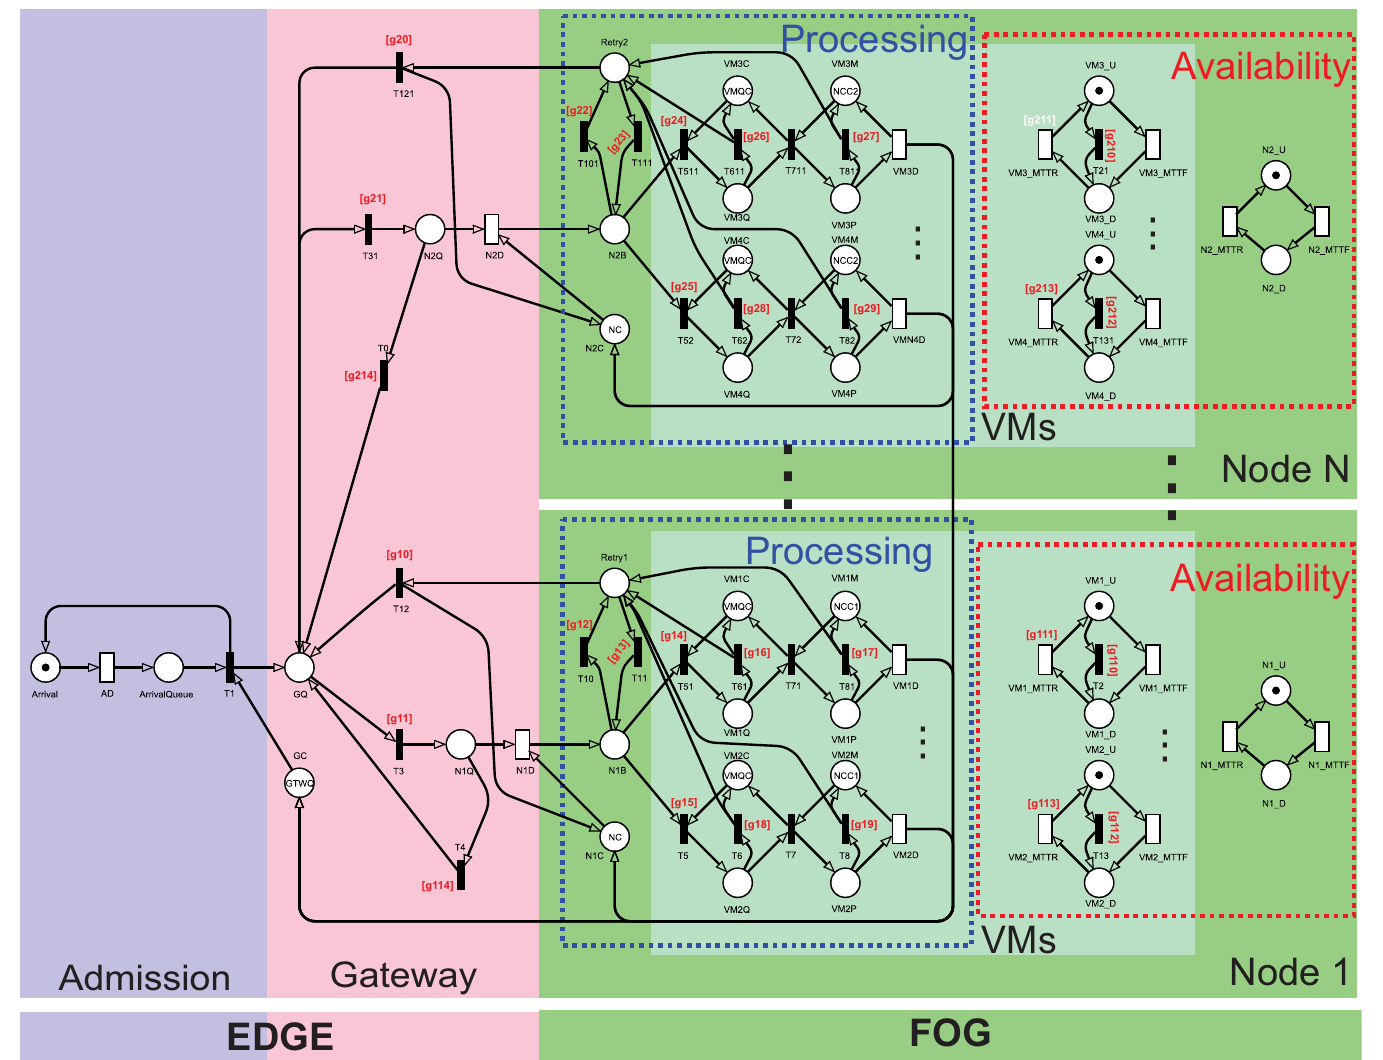
Figure 3. Overall SRN system